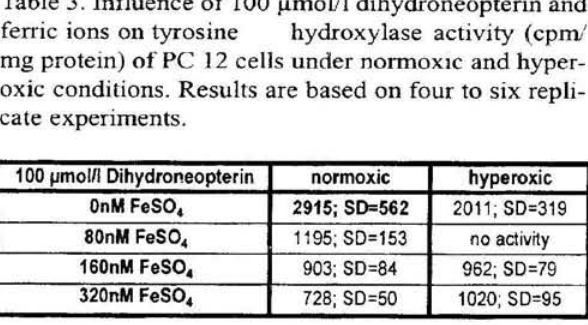
Table 3. Influence of 100 μπιοΐ/ΐ dihydroneopterin and ferric ions on tyrosine hydroxylase activity